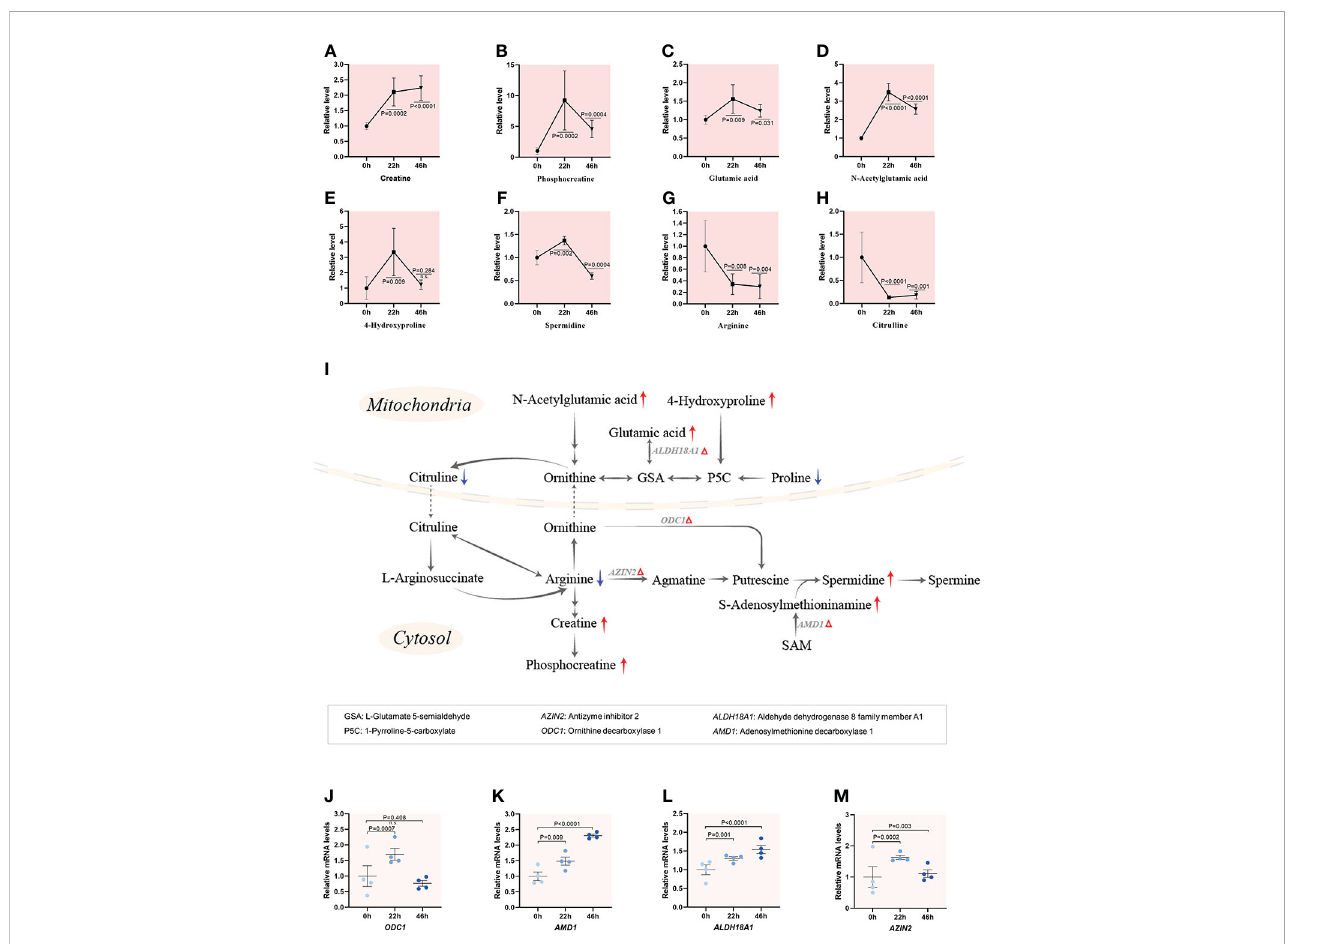
FIGURE 4 Enhanced catabolism of arginine and proline during meiotic resumption. (A – H) Relative levels of metabolites involved in arginine and proline metabolism in oocytes at three time points. (I) Schematic diagram of arginine and proline metabolism during meiotic resumption, based on metabolomics and transcriptomics. The red and blue arrows denote the metabolites that were upregulated and downregulated, respectively. Differential expression genes increased are indicated by red triangles. (J – M) Relative levels of differential expression genes related to arginine and proline metabolism during meiotic resumption. Error bars, SD. Student ’ s t test was used for statistical analysis in all panels, comparing to GV. n.s., not signi fi